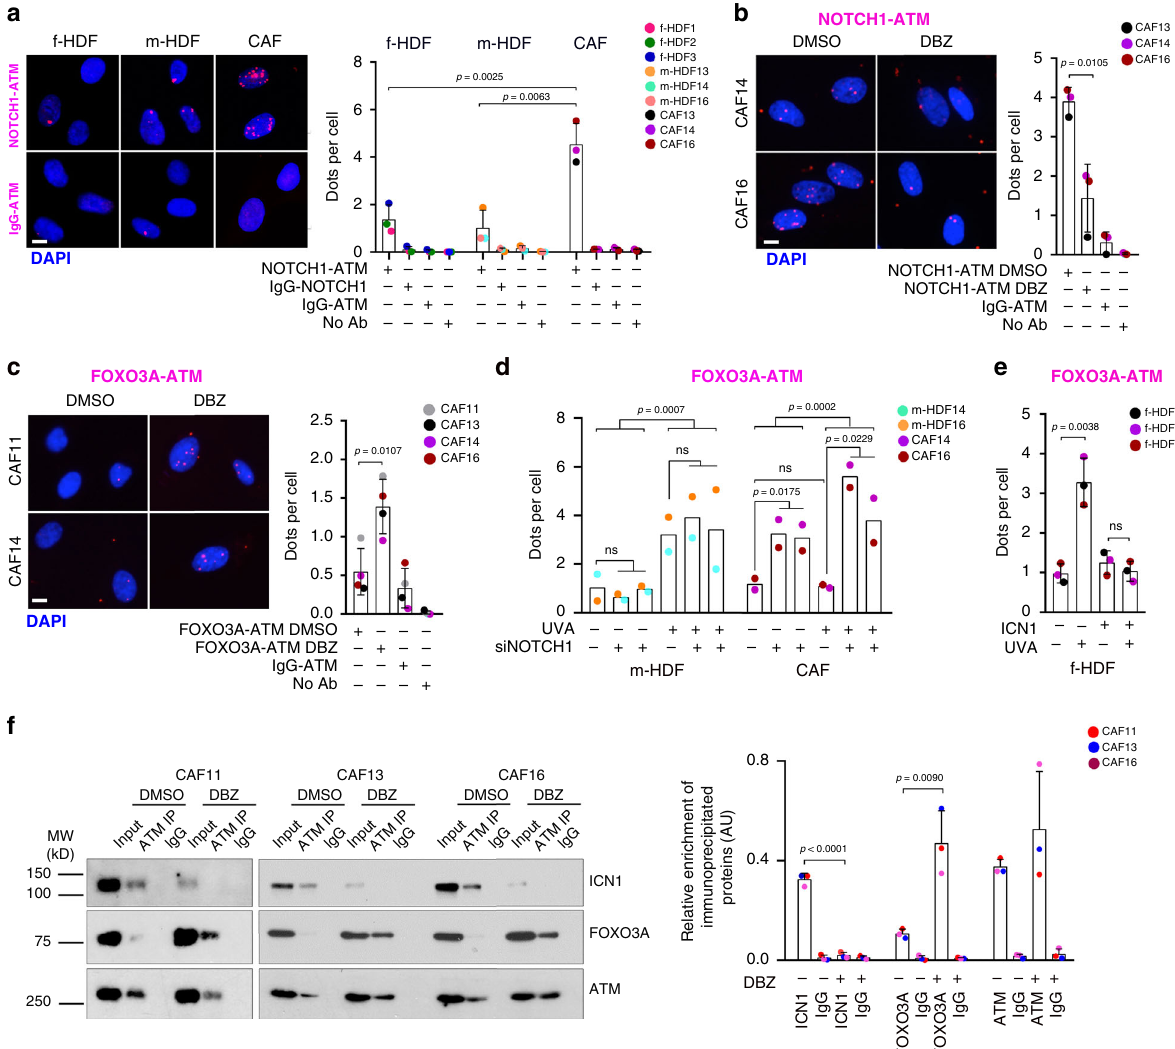
Fig. 5 NOTCH1-ATM and ATM-FOXO3A complex formation in HDFs and CAFs. a Proximity ligation assays (PLAs) with antibodies against ATM and NOTCH1 of multiple f-HDF, m-HDF, and CAF strains. b , c PLAs of CAF strains plus/minus treatment with DBZ (10 μ M) for 5 days with antibodies against ATM and NOTCH1 ( b ) or ATM and FOXO3A ( c ). d , e PLAs with antibodies against ATM and FOXO3A of m-HDF and CAF strains plus/minus siRNA- mediated silencing of NOTCH1 and UVA irradiation as indicated (500 mJ/cm 2 ) ( d ), and of f-HDF strains plus/minus infection with an ICN1 expressing lentivirus for empty vector control for 5 days and UVA irradiation (500 mJ/cm 2 ) for the last 72 h ( e ). IgG-NOTCH1, IgG-ATM, and no primary antibodies were used as negative controls. Shown are representative images and quanti fi cation of average number of PLA puncta (dots) per cell per strain, counting in each case. Scale bar, 2 μ m. a n (cells) >78, n (f-HDF strain) = 3, n (m-HDF strain) = 3, n (CAF strain) = 3; b n (cells)> 100, and n (CAF strain) = 3; c n (cells) > 74, n (CAF strain) = 4; d n (cells) > 74, n (m-HDF strain) = 2, n (CAF strain) = 2; e n (cells) > 72, and n (f-HDF strain) = 3. Two-tailed unpaired t -test within groups in a – e and two-way ANOVA among groups in d . * p < 0.05, ** p < 0.01, *** p < 0.001. f Co-immunoprecipitation (co-IP) assays of CAF strains plus/ minus DBZ (10 μ M) treatment for 5 days with anti-ATM antibodies or non-immune IgG followed by immunoblotting, together with equal input amounts, with antibodies against the ICN1, FOXO3A, and ATM proteins. Right panel: densitometric quanti fi cation for the indicated proteins normalized to input. Mean± s.d. two-tailed unpaired t -test, ** p < 0.01, **** p < 0.0001. n (CAF strain) =